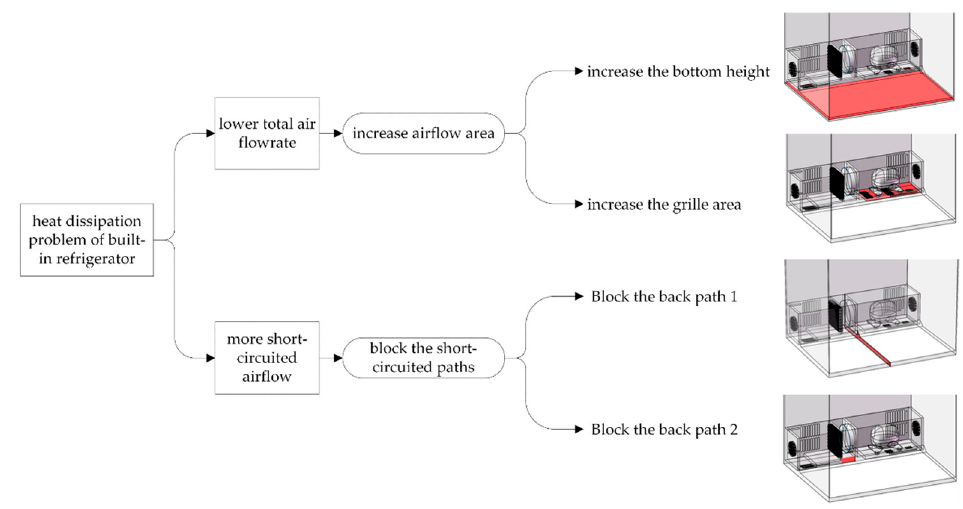
Figure 7. Flow chart of solution ideas and specific approaches to heat dissipation deterioration in built-in refrigerators.